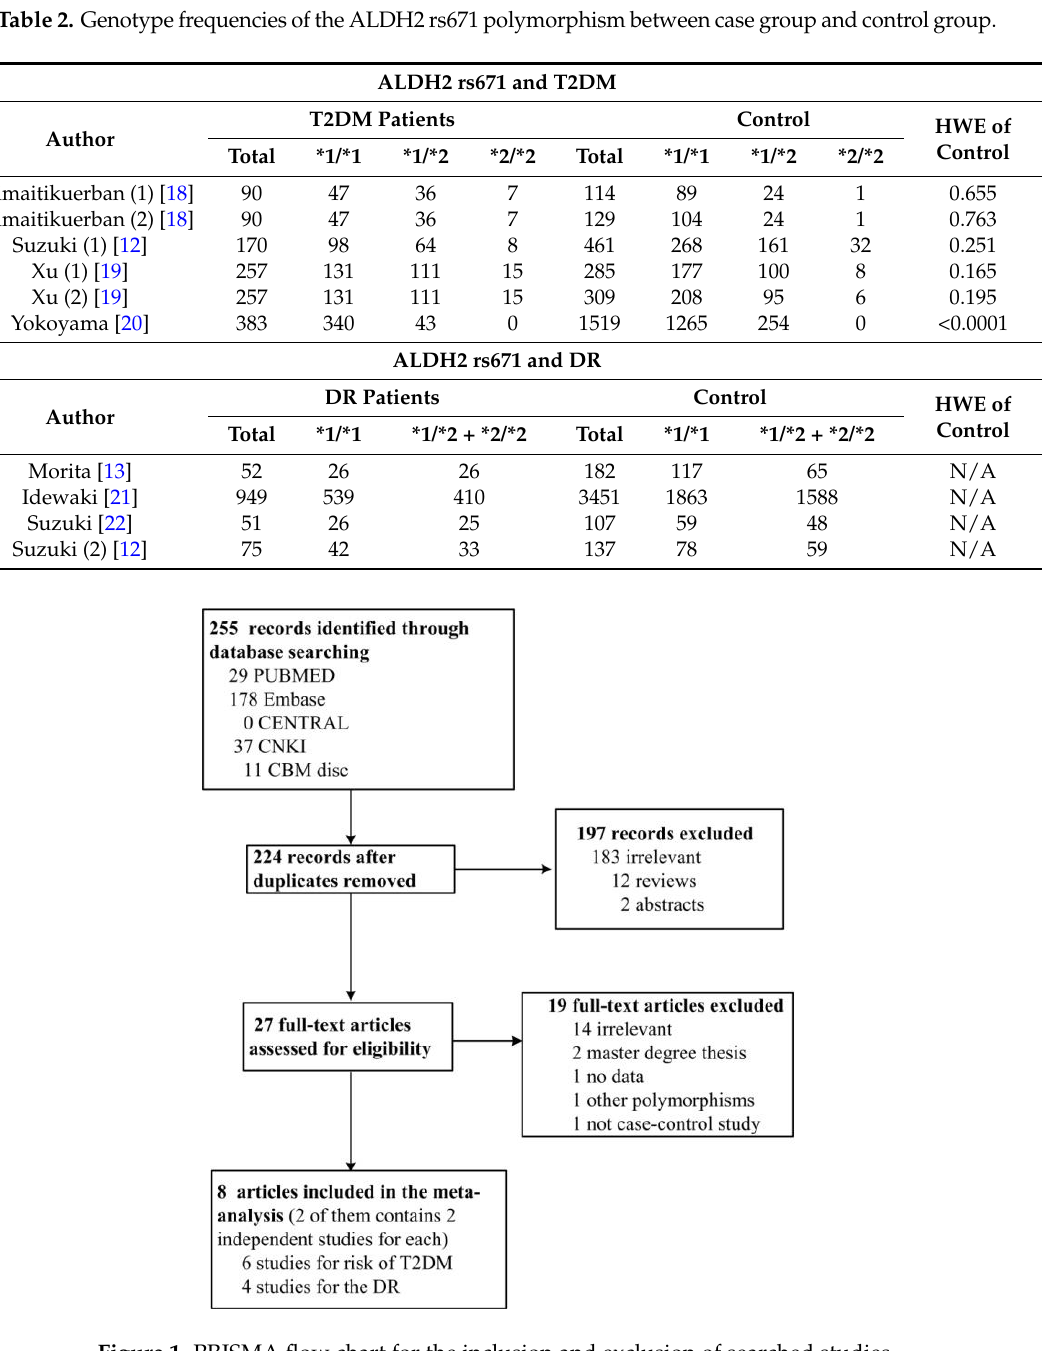
Figure 1. PRISMA flow chart for the inclusion and exclusion of searched studies.